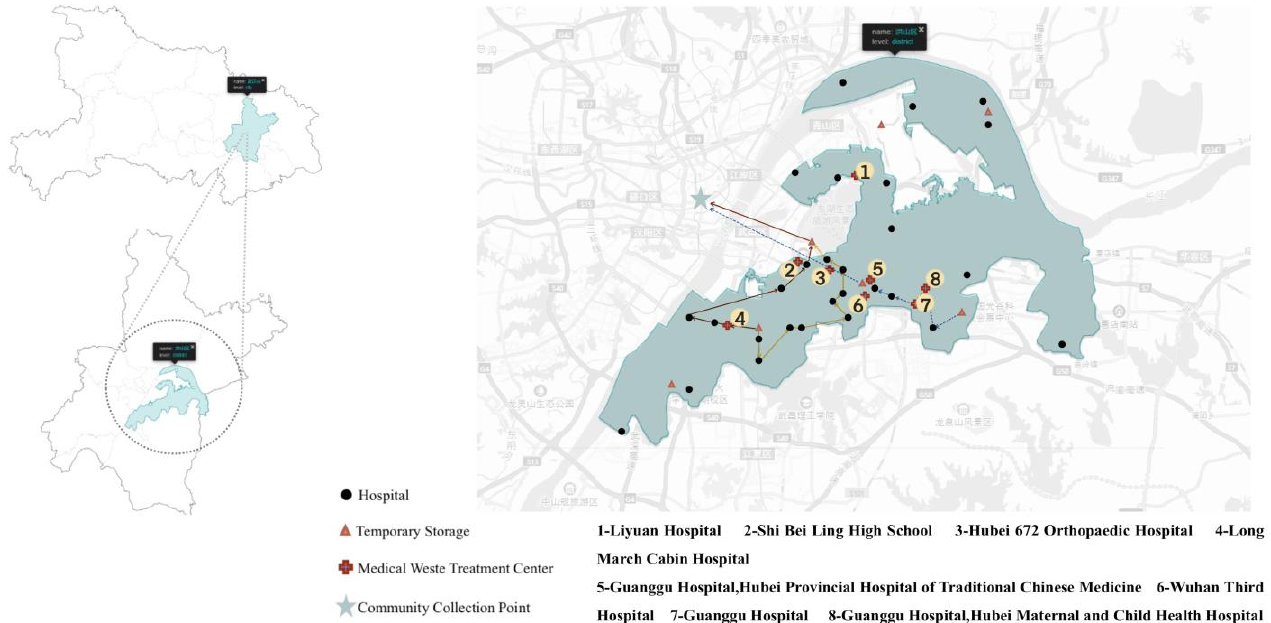
Figure 5. Partial interception in Hongshan District based on the path planning of temporary storage system.